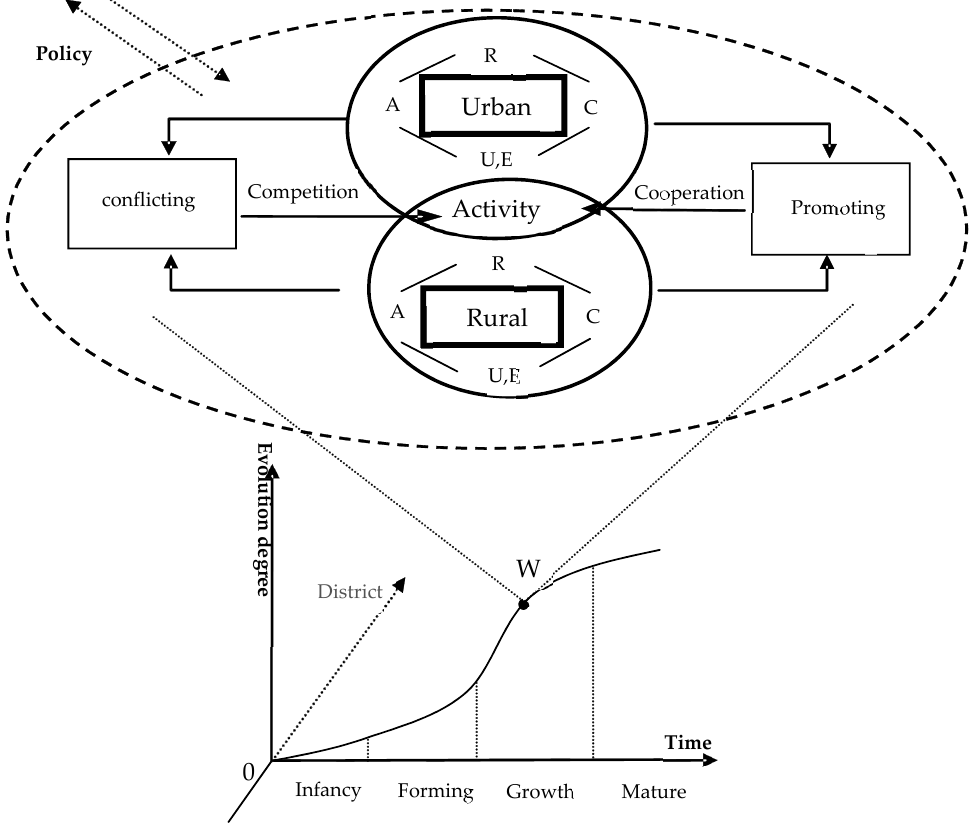
Figure 2. The synergetic evolution mechanism of urban-rural complex system.